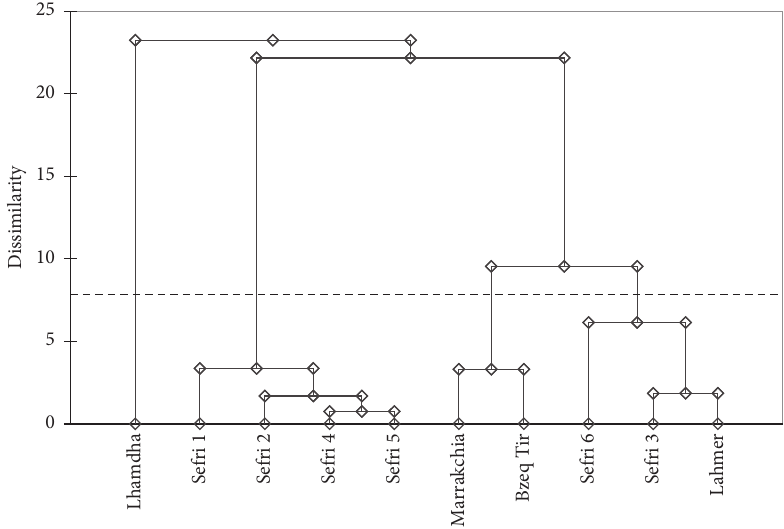
Figure 2: Dendrogram of ten Moroccan pomegranate cultivars based on physicochemical and biochemical characteristics of their seed